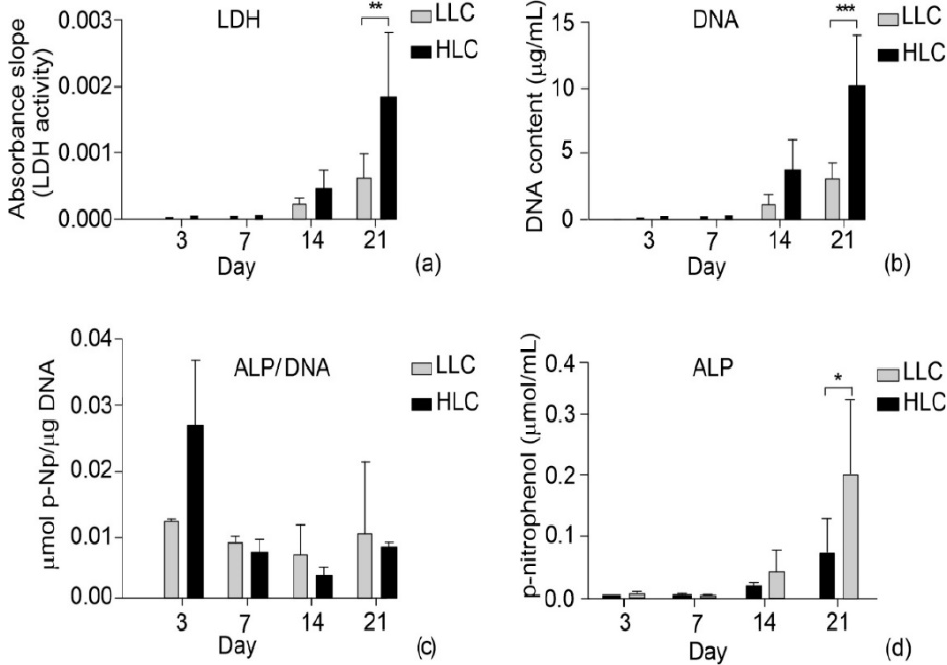
Figure 17. Viability (LDH activity) ( a ), quantification of DNA ( b ), sample-specific differentiation (ALP activity/DNA) ( c ), and differentiation (ALP activity) ( d ) over 21 days of cells seeded on top of LLC and HLC scaffolds, p < 0.05(*), p < 0.01(**), p < 0.001(***).